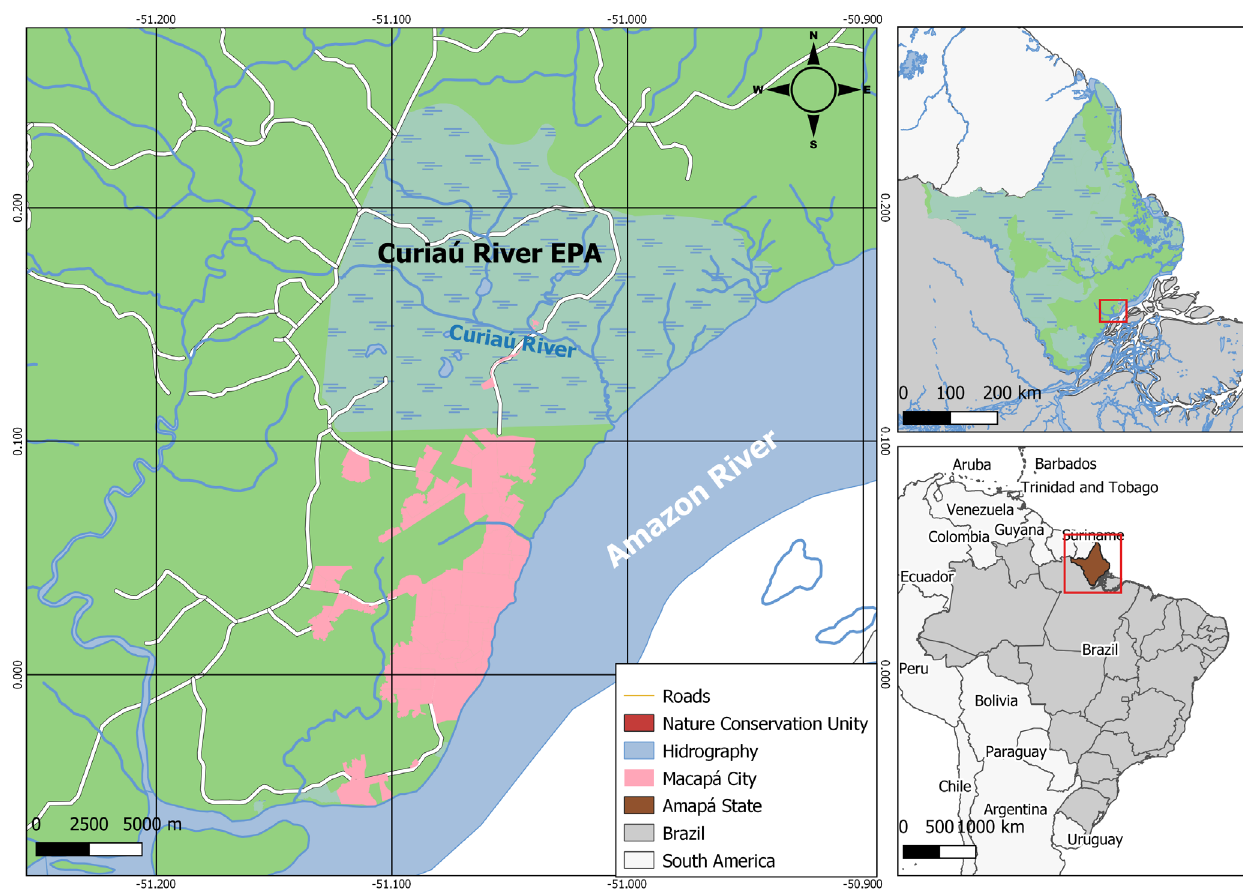
FIGURE 1 | Study area: Curiaú River Environmental Protection Area in Macapá, Amapá,